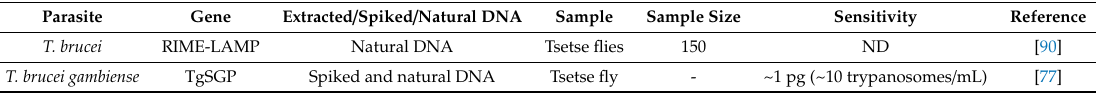
Table 7. Publications found in the US National Library of Medicine National Institutes of Health (NCBI-PubMed) reporting the standardisation of the LAMP technique as a useful tool for diagnosing HAT (sleeping sickness) in the